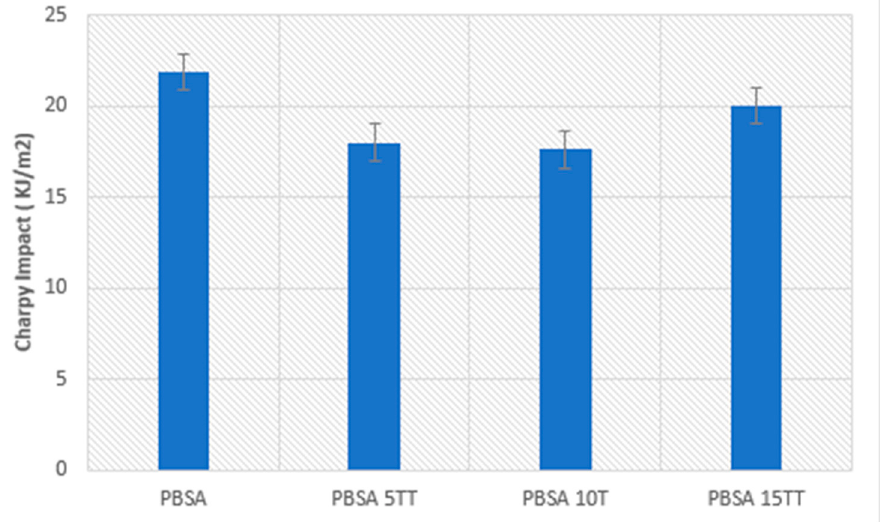
Figure 9. Charpy impact strength as a function of wood content.